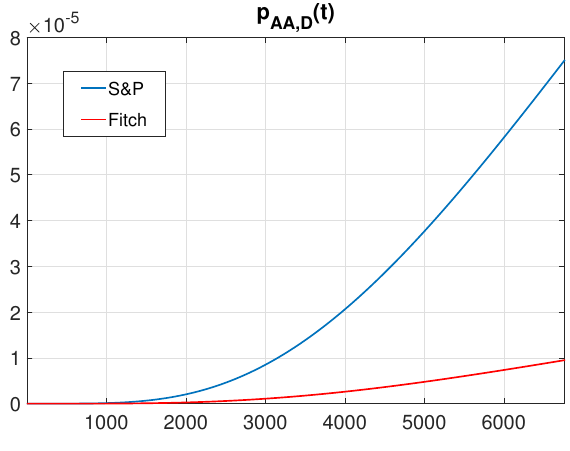
Figure 7. p 2,8 for Fitch, Standard and